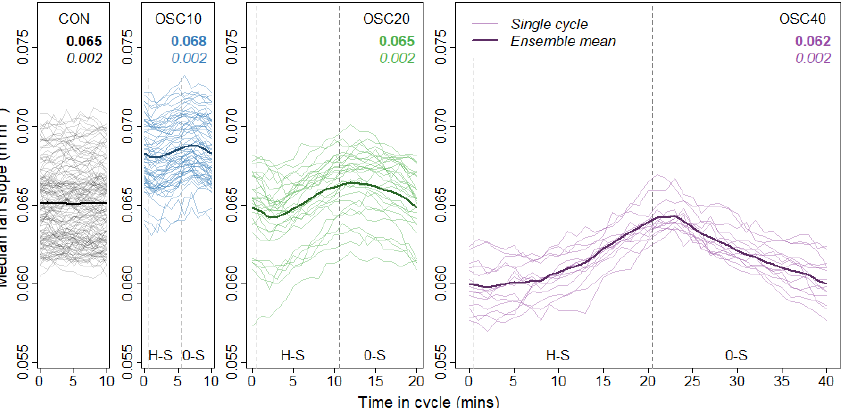
Figure 5. Median fan slope (for the whole fan) versus time in the sediment supply oscillation cycle. The thin lines represent each individual supply oscillation cycle; the thick line is the ensemble mean. H-S denotes the high-supply period; 0-S denotes zero sediment supply. Coloured text indicates each experiment’s time-averaged mean (in bold) and standard deviation (in